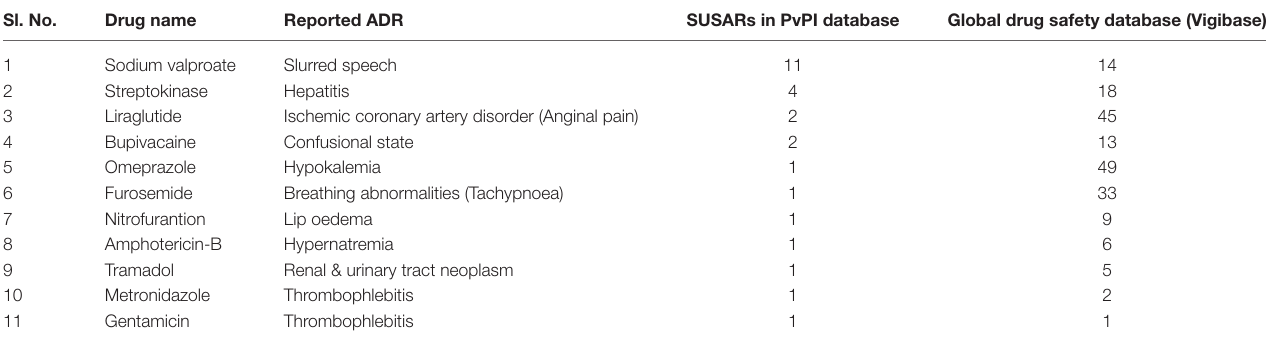
TABLE 1 | SUSARs reported during 2011–2013. Sl.